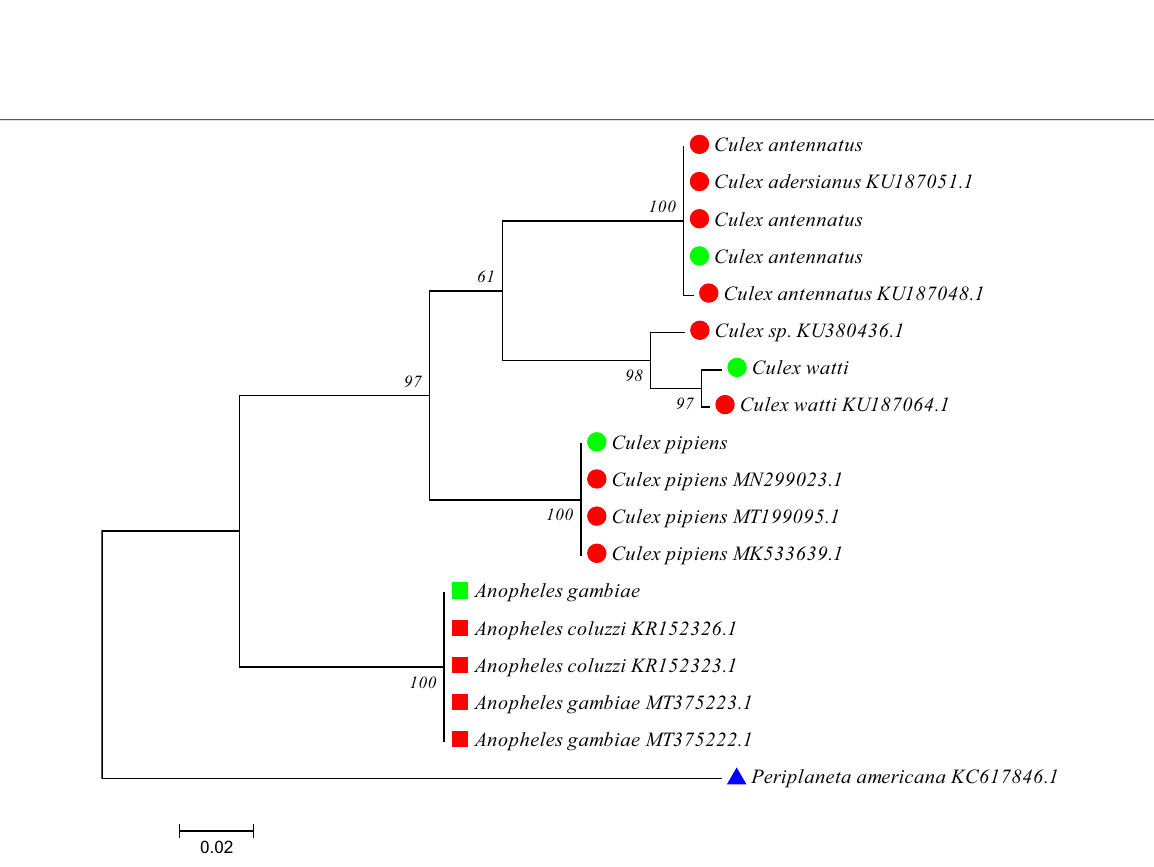
Fig. 4 Molecular phylogenetic analysis of the mitochondrial cytochrome oxidase subunit I ( COI ) region of mosquito species by Maximum Likelihood method inferred by Tamura‑Nei method after 1000 replications. Periplaneta americana was used as an